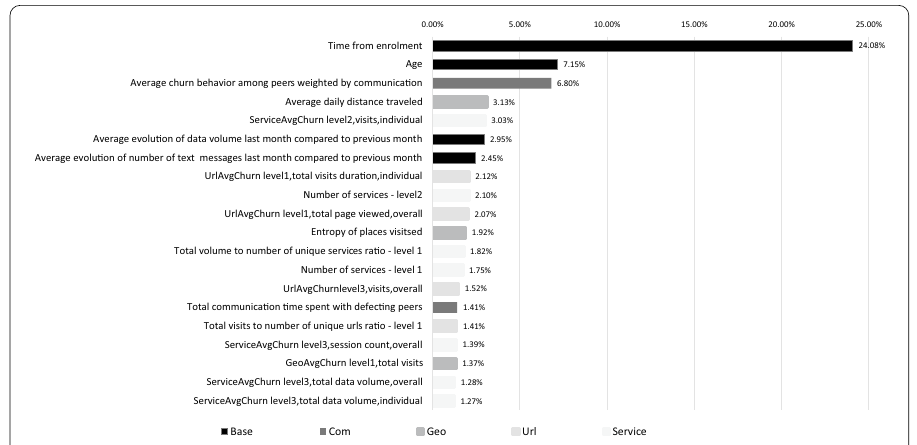
Fig. 6 Essence Random Forest full model (500 trees): variable importance